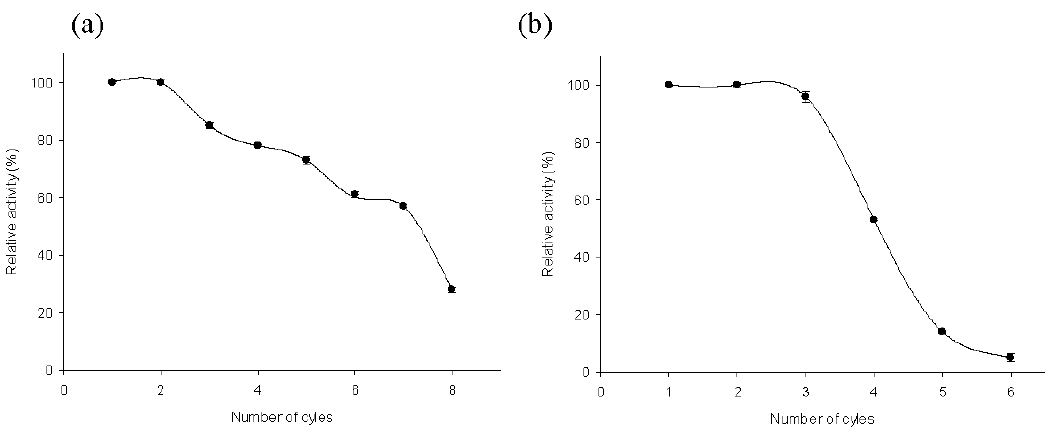
Figure 4. Recycling of M Tt HGXPRT derivatives in the enzymatic production of inosine-5′-monophosphate (IMP). ( a ) M Tt HGXPRT3; ( b ) M Tt HGXPRT5.